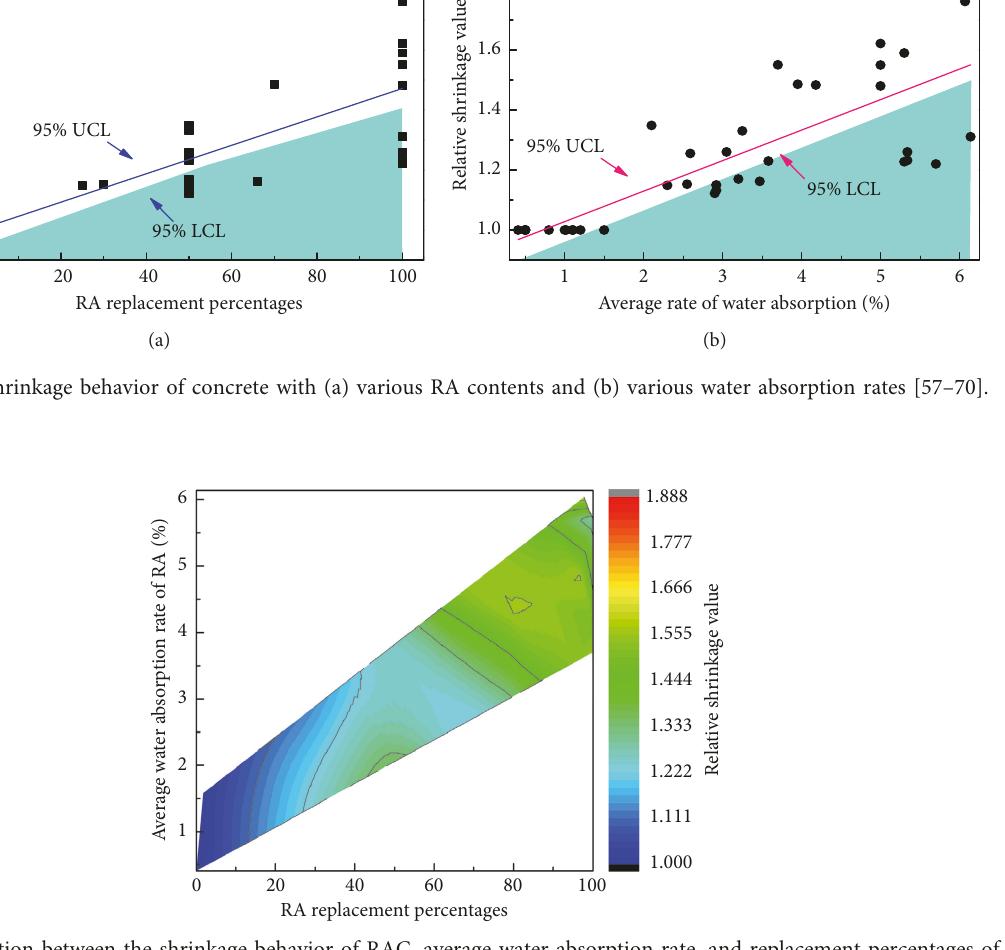
Figure 4: Correlation between the shrinkage behavior of RAC, average water absorption rate, and replacement percentages of